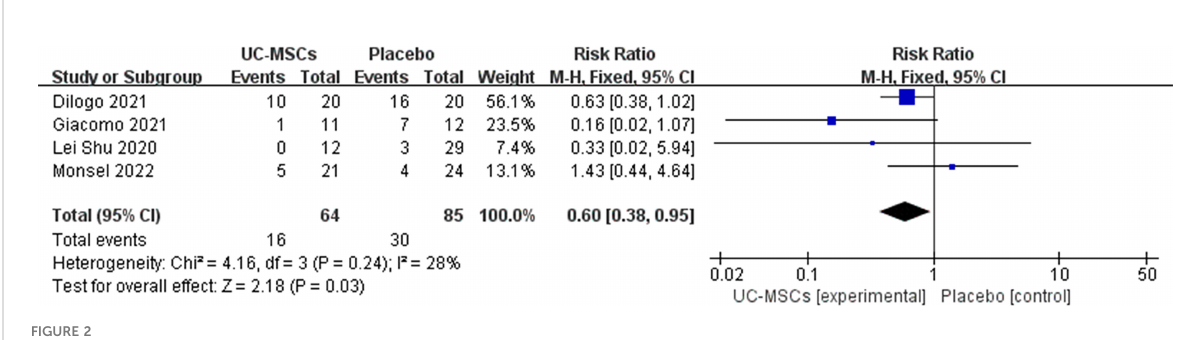
FIGURE 2 The effect of UC-MSCs therapy by forest plot diagram on COVID-19 mortality